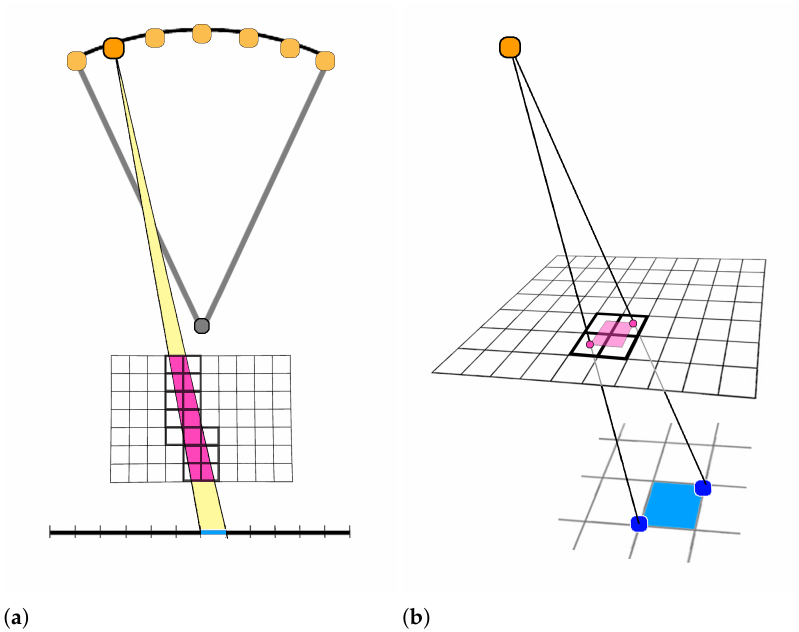
Figure 2. Schematic draw representing the Distance Driven approach to compute the system matrix. ( a ) View on the YZ plane of an X-ray projection onto a single pixel, from a fixed angle. The intersection of the X-ray beam with the volume is highlighted in magenta. ( b ) The magenta area represents the backward projection of the blue recording unit onto a volume slice parallel to the XY